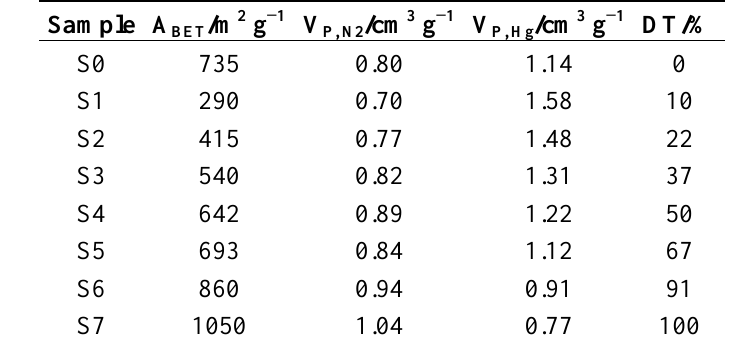
Table 2. Specific surface area A , specific pore volume V BET sorption (index: N ) and mercury intrusion (index: Hg), porosity and degree of 2 transformation